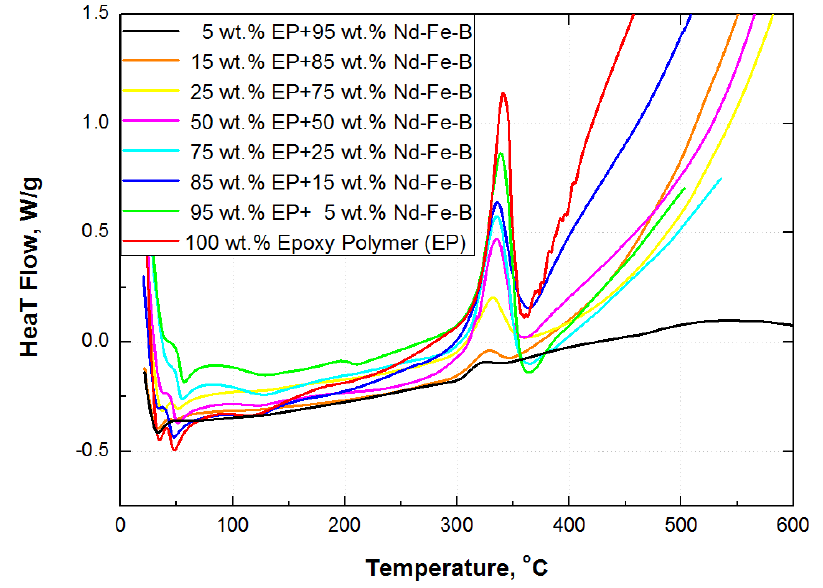
Figure 5. DSC curves of composites and pure epoxy resin.